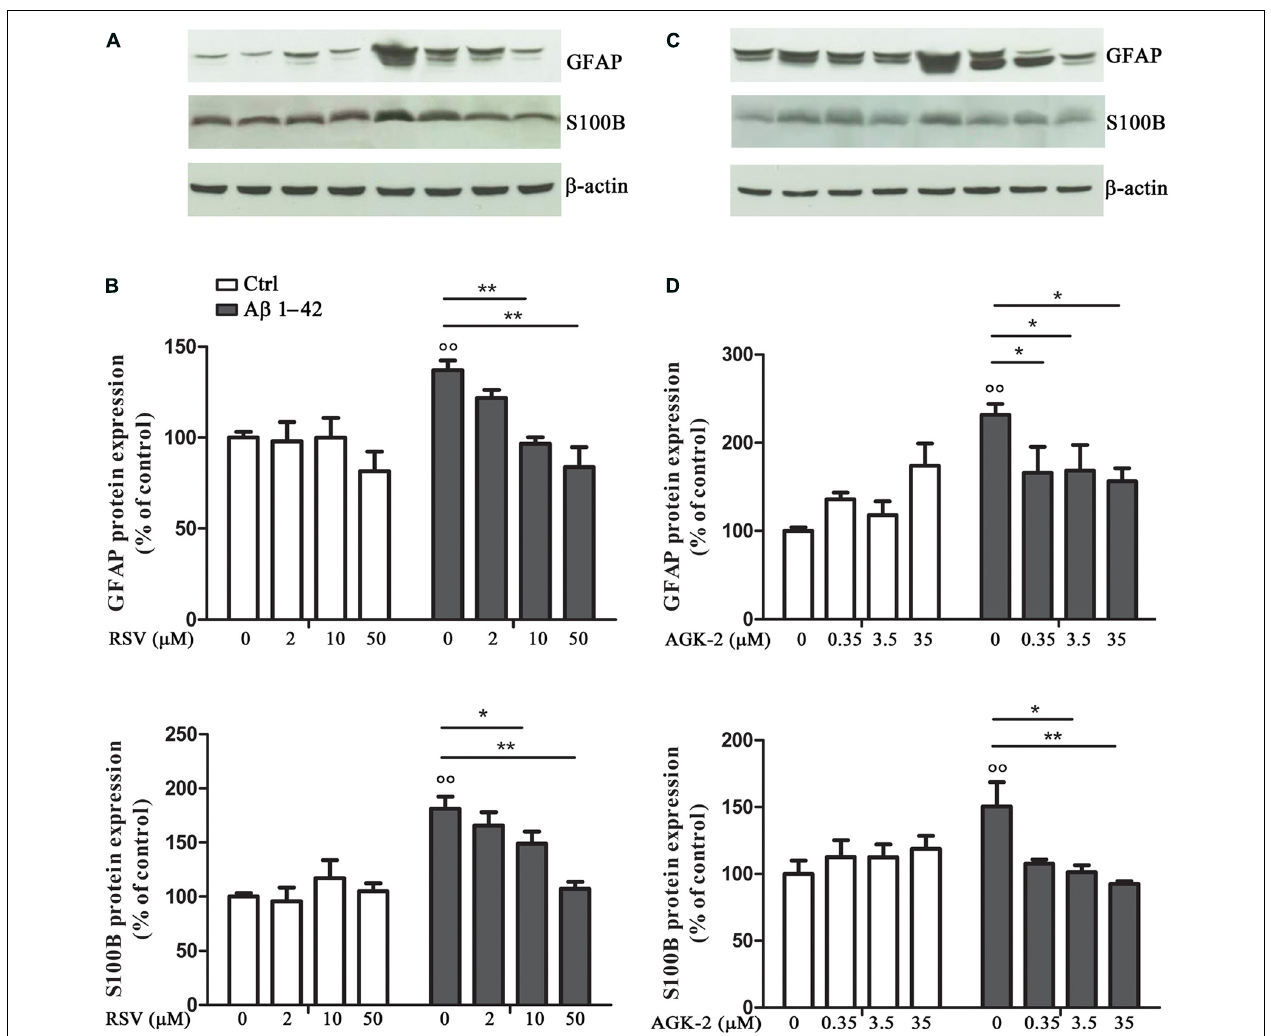
analyzes normalized to β -actin loading controls ( B,D for RSV and AGK-2, respectively). Results are the mean ± SEM of four experiments in triplicate. Statistical analysis was performed by one-way ANOVA followed by Bonferroni multiple comparison test. p < 0.01 A β -challenged versus unchallenged cells; * p < 0.05; ** p < 0.01; for multiple comparison among